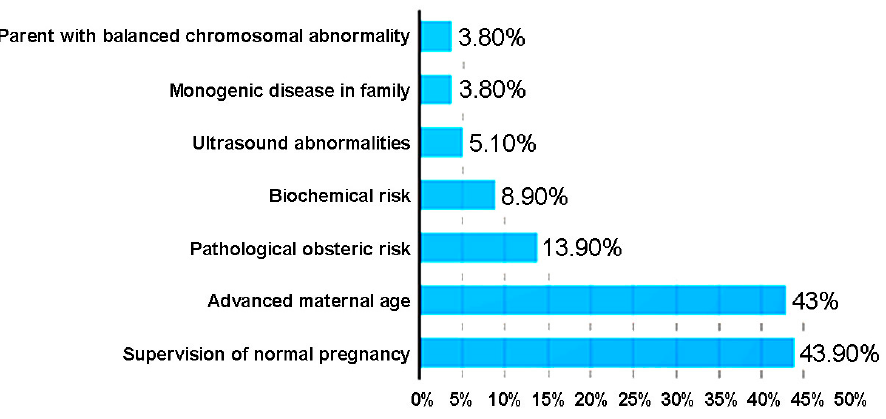
Figure 4. Indications for the NIPT.